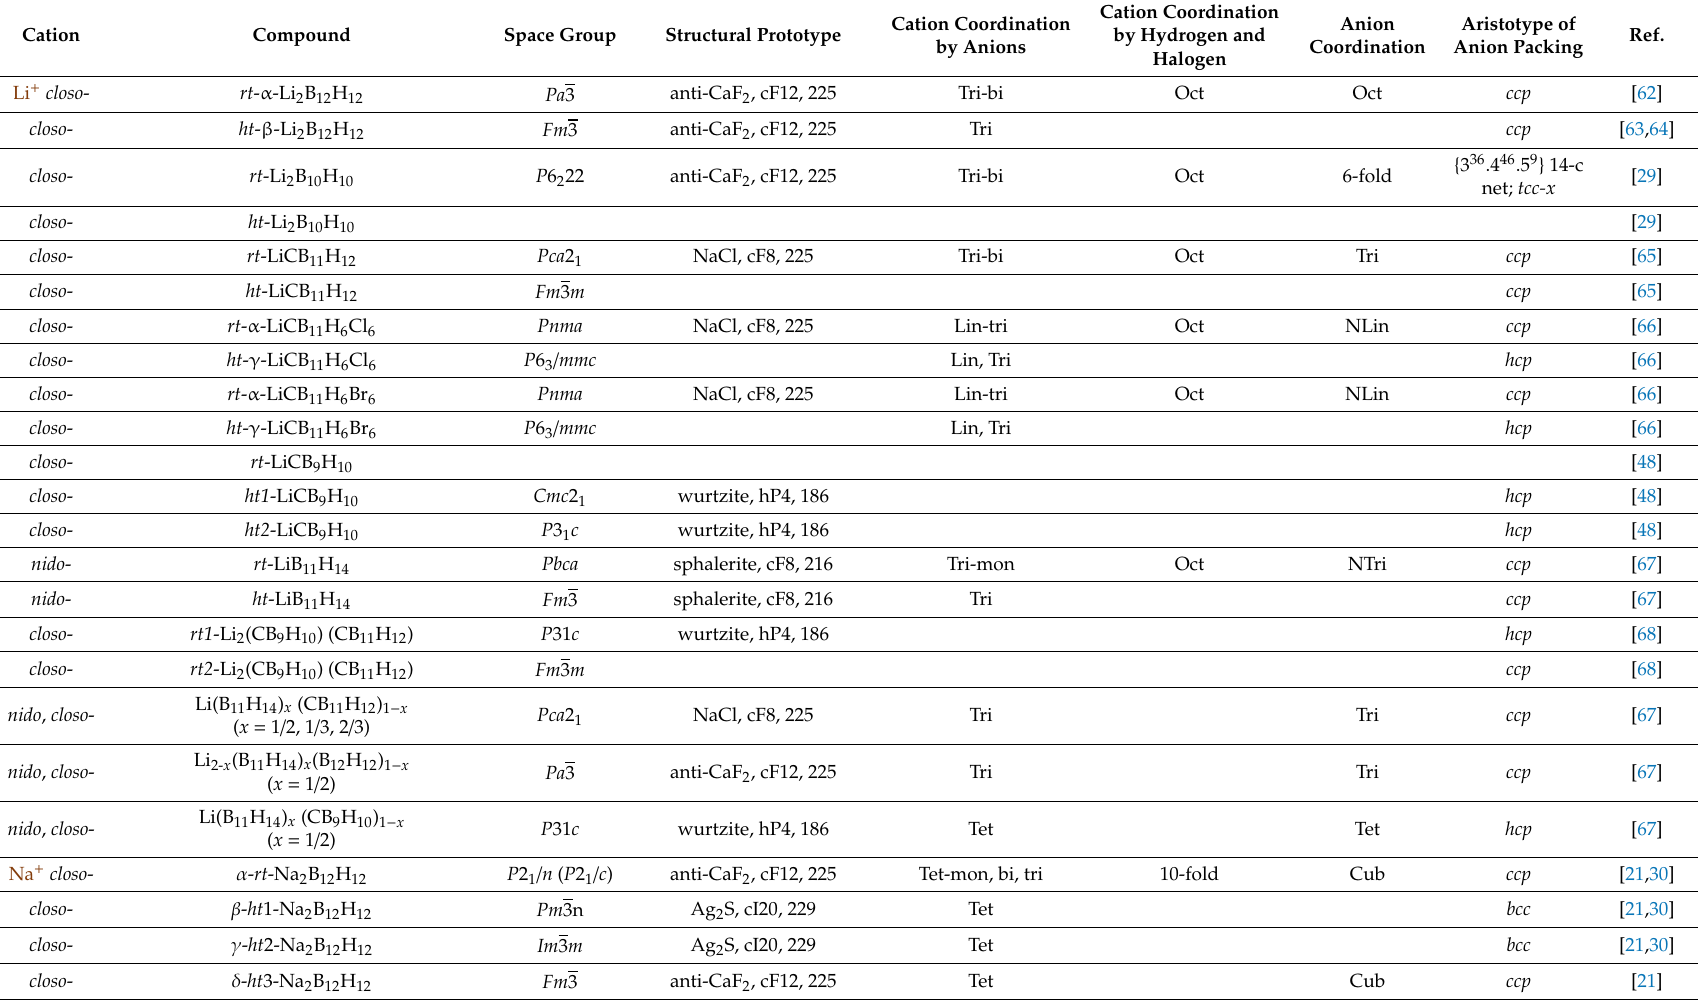
Table 1. Structural classification of single cation metal